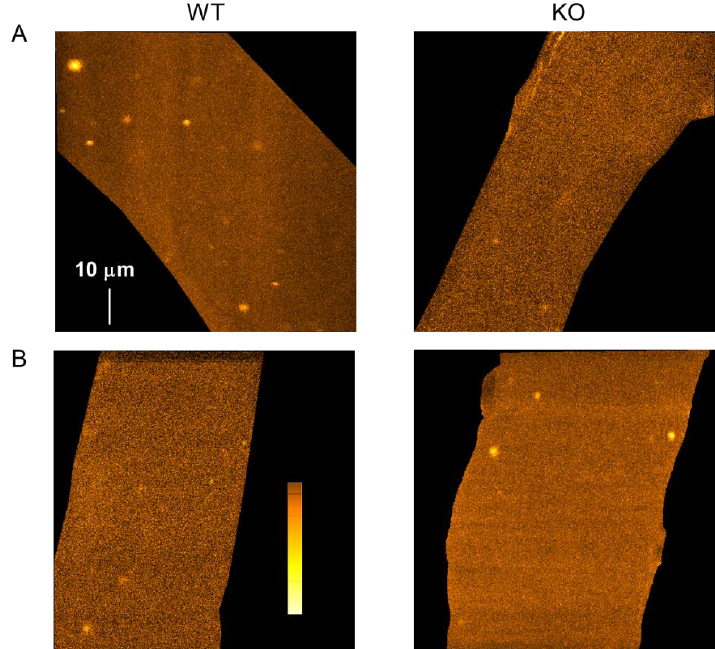
Figure 4. Spontaneous Ca 2+ release events in saponin-permeabilized FDB fibers. Representative composite XY images from 4-month-old ( A ) and 10-month-old ( B ) WT (left panels) and sAnk1 KO (right panels) mice. Changes in [Ca 2+ ] i were visualized by loading the fibers with fluo-3. Each image is the composite of 120 images recorded with a frequency of 16 Hz. The scale bar in the top left image corresponds to all images. The color bar in the bottom left image corresponds to all images. Lighter colors represent a higher change in [Ca 2+ ] i .